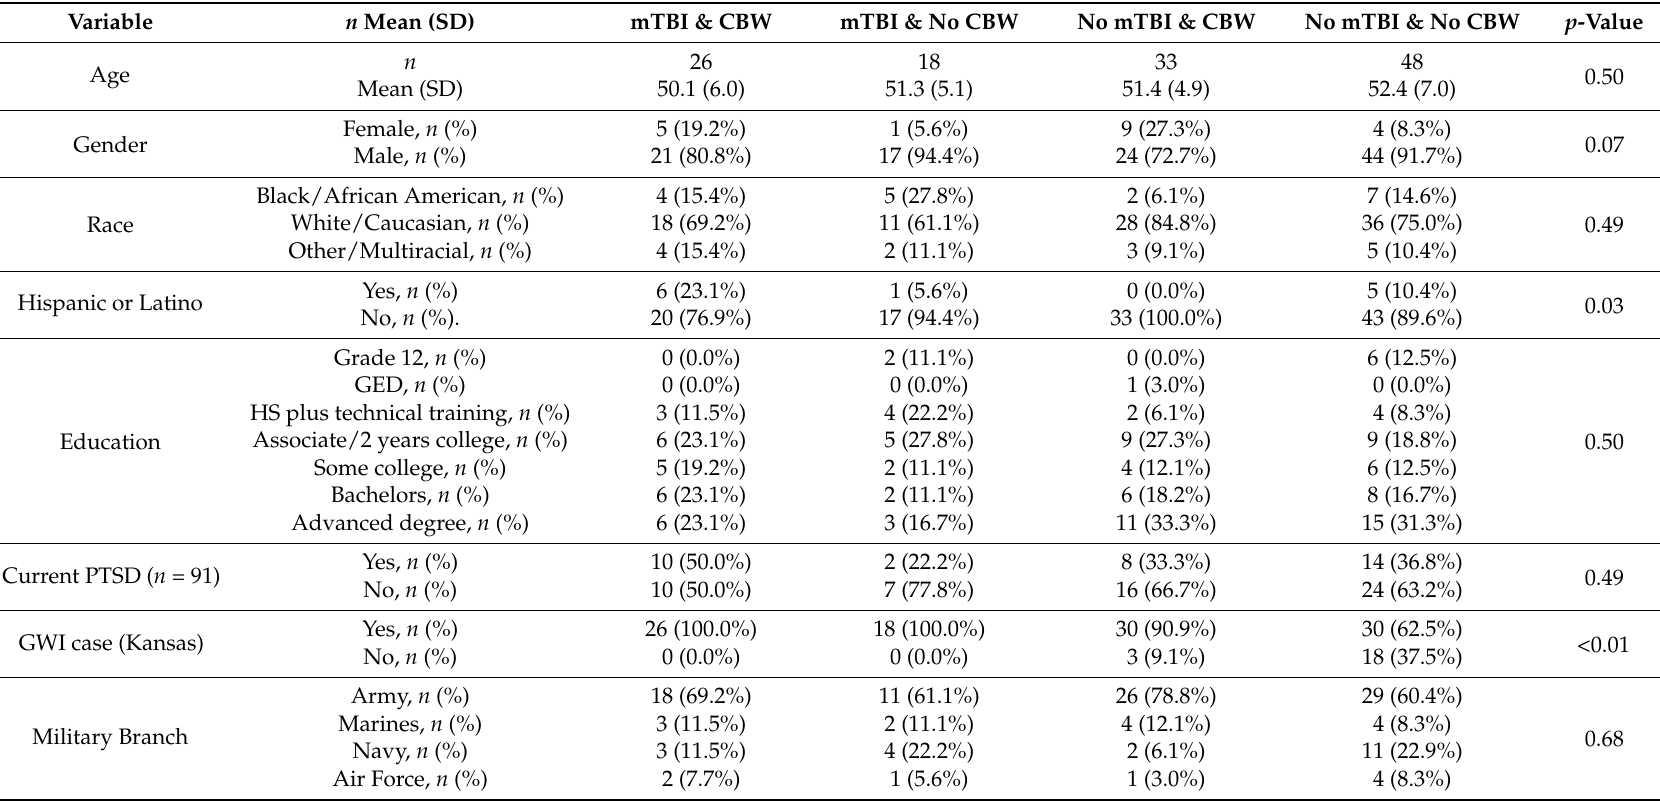
Table 2. Demographic characteristics by mTBI and chemical/biological weapon (CBW) exposure